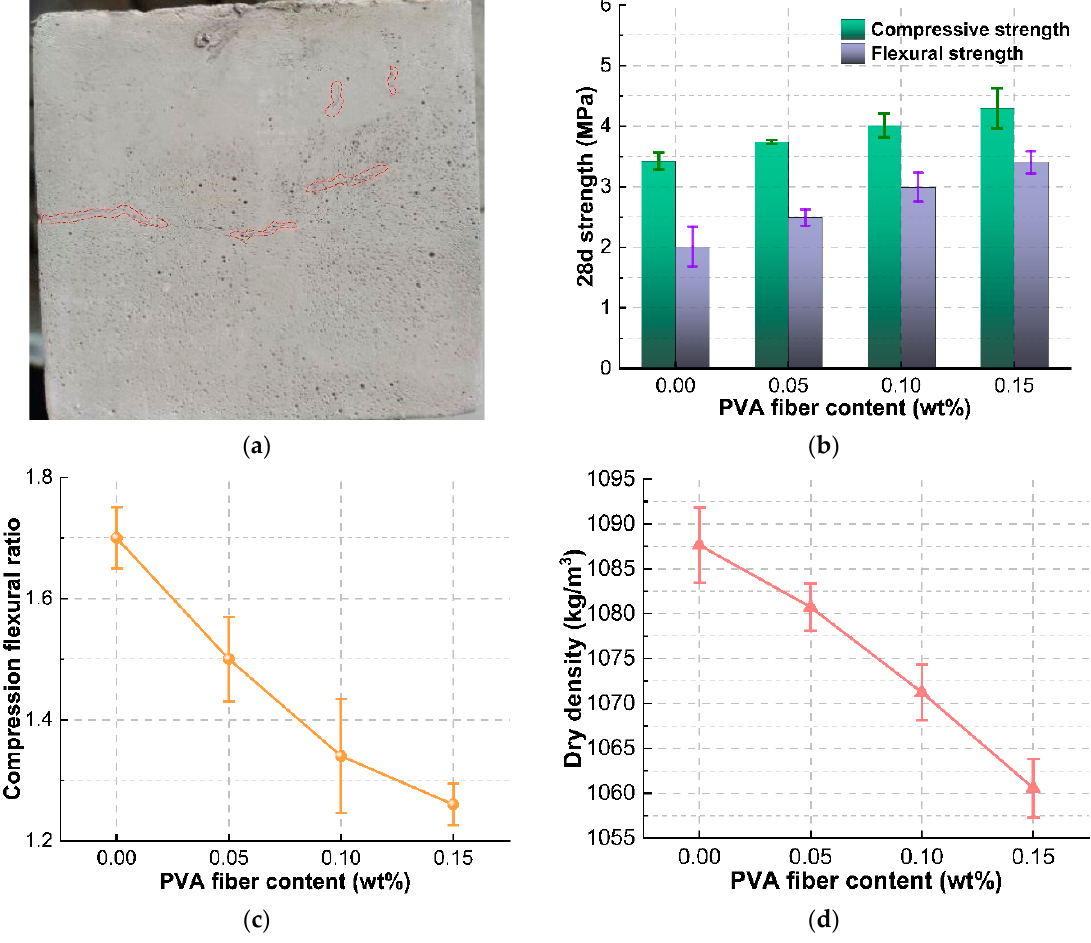
Figure 11. ( a ) Micro cracks on the surface of foamed concrete specimens; ( b ) Effect of PVA fiber content on compressive and flexural strength; ( c ) Effect of PVA fiber content on compression flexural ratio; ( d ) Effect of PVA fiber content on dry density.